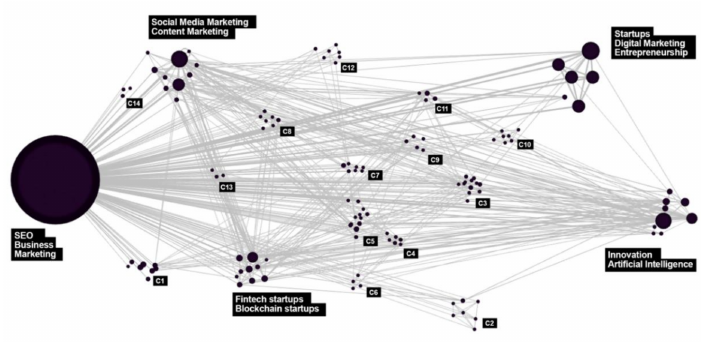
Figure 3. Groups of communities associated by similar content. Source: The authors.